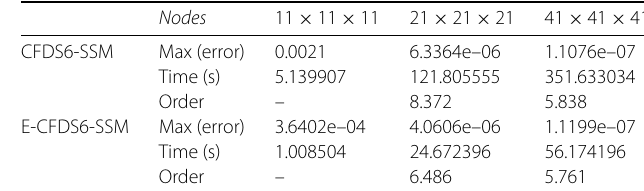
Table 8 The convergence order and computational time for SP 5 at t = 2 Nodes